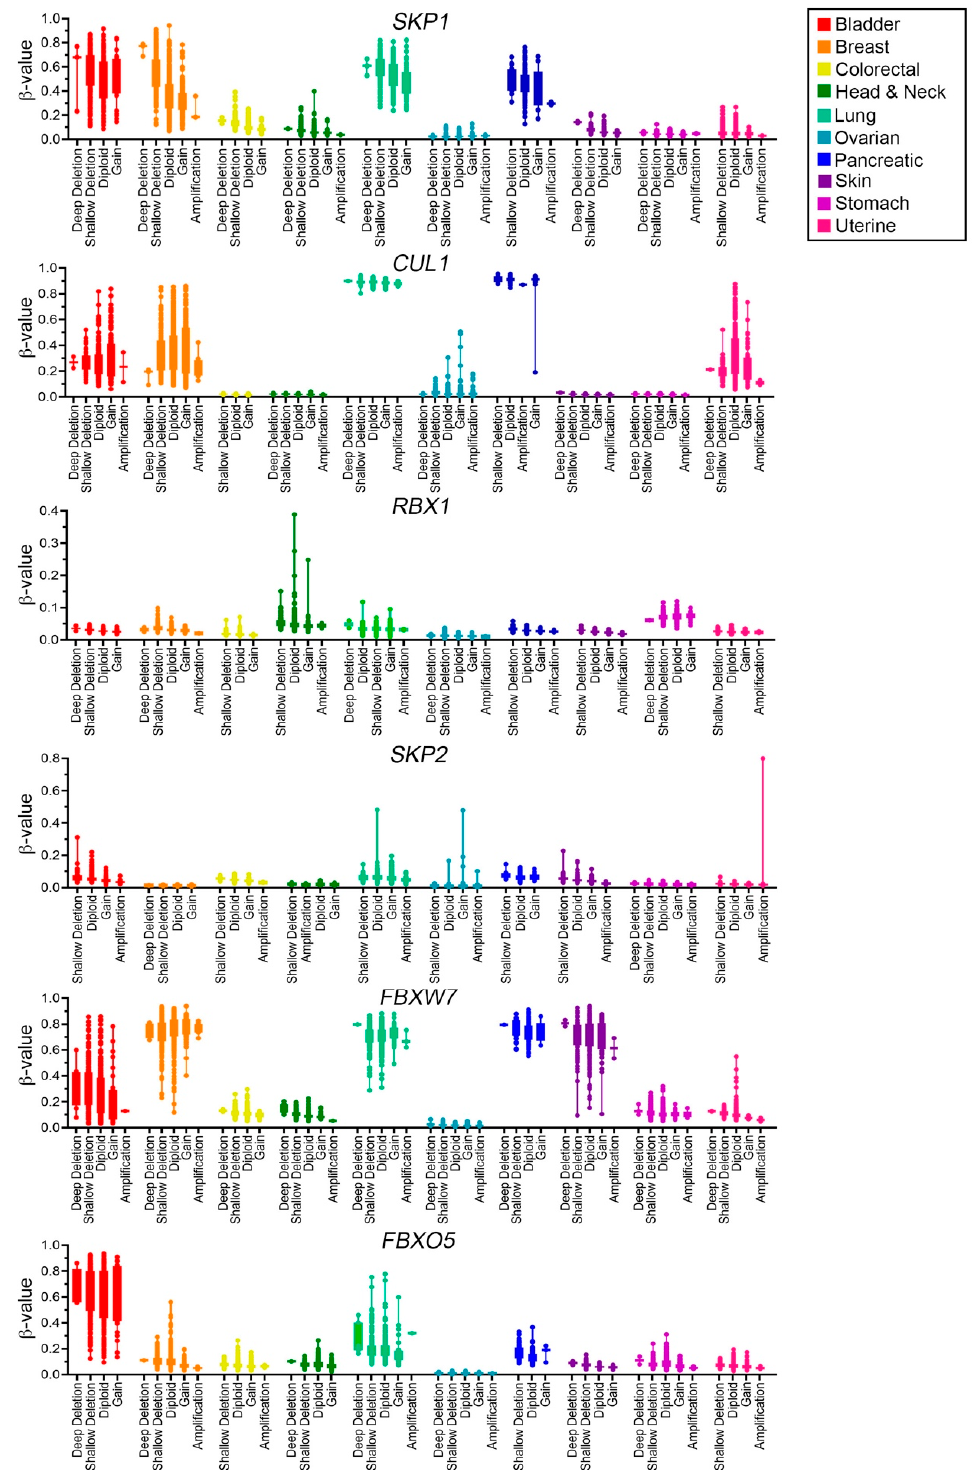
Figure 7. The SCF complex is differentially methylated in human cancers. Box-and-whisker plots presenting the methylation status of cancer samples derived from TCGA Firehose Legacy data (https://gdac.broadinstitute.org/, accessed on 19 December 2021) (see Tables S4–S9). Associated β -values of SCF complex members are presented along the y -axis. Note that the y -axis scale for RBX1 and SKP2 (0.4 and 0.8, respectively) differ relative to the remaining genes (1.0) for better data visualization. Methylation data are grouped according to gene CNAs (deep deletion; shallow deletion; gain; amplification) or diploid status ( x